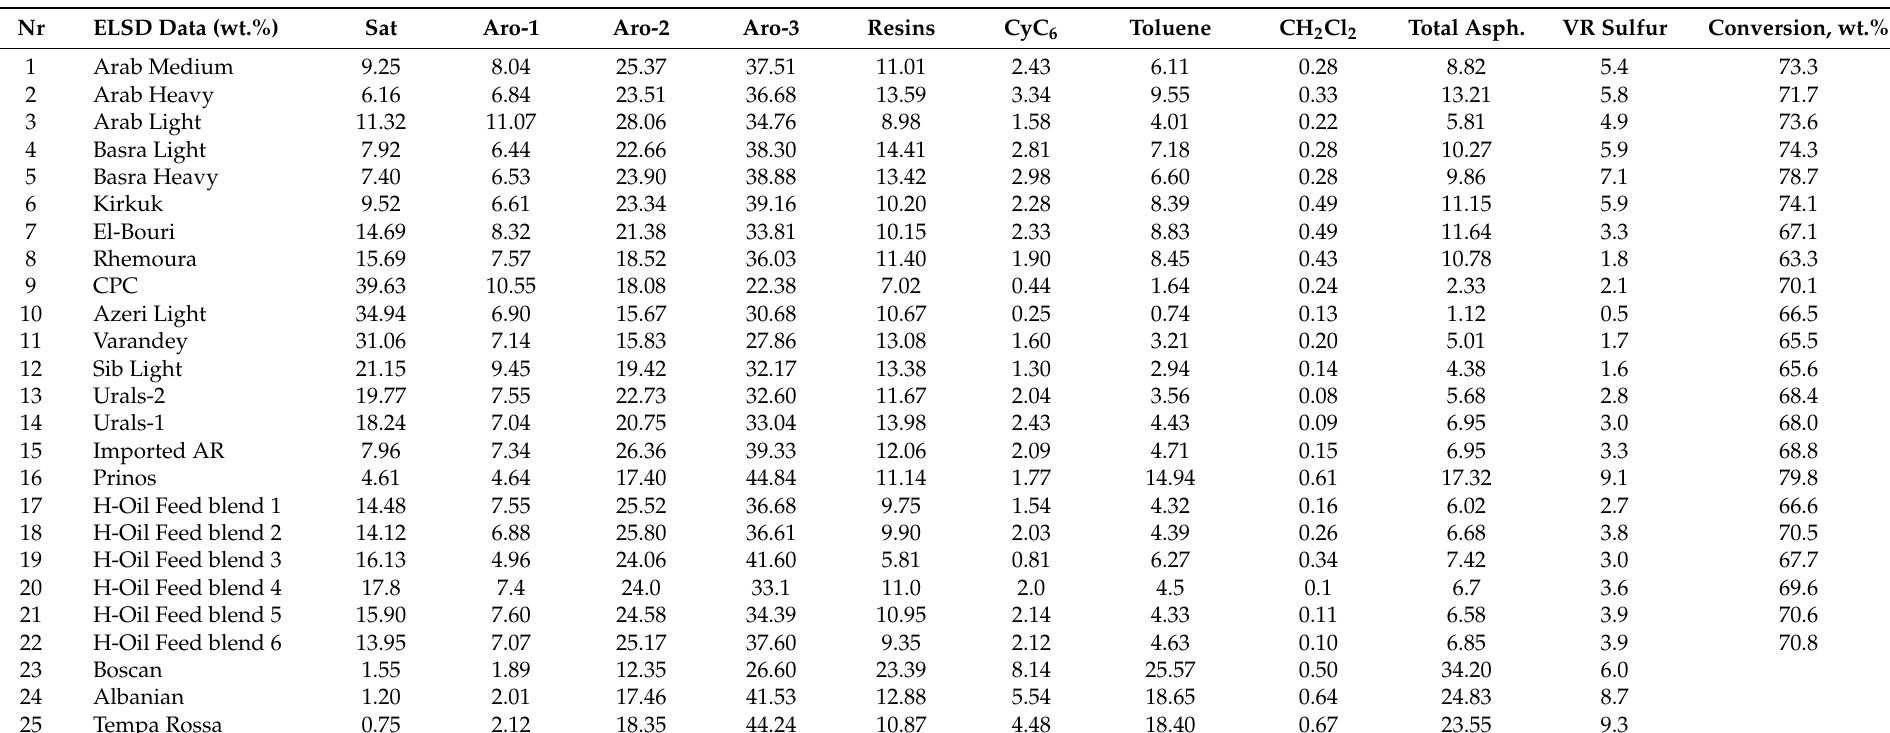
Table 8. SAR-AD composition of studied individual straight-run vacuum residues and determined by the use of the approximate linear combination technique conversion levels at the same sediment formation rates observed at the commercial ebullated bed